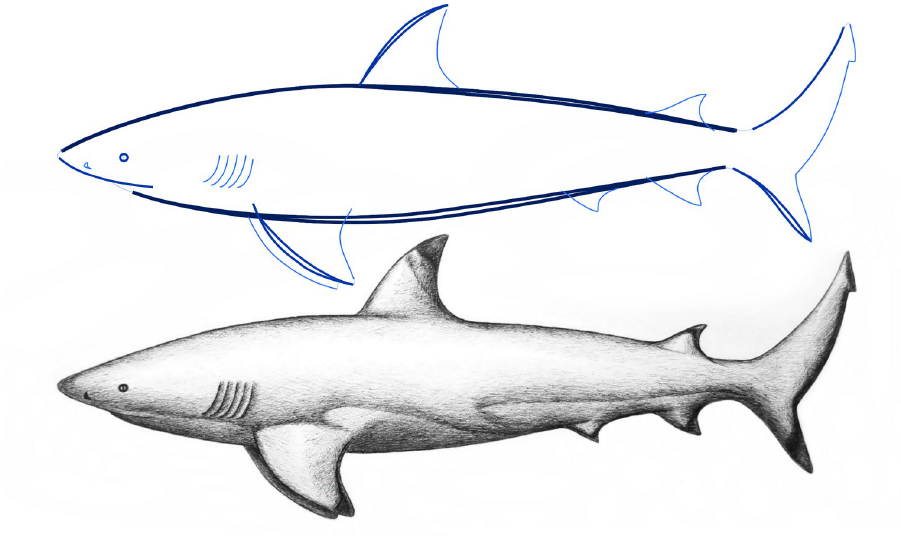
Fig 2. Drawing a blacktip shark, sketching as a reflective conversation. The curves (top) are thicker and darker the more important they are for establishing and discovering the general character of the drawing.